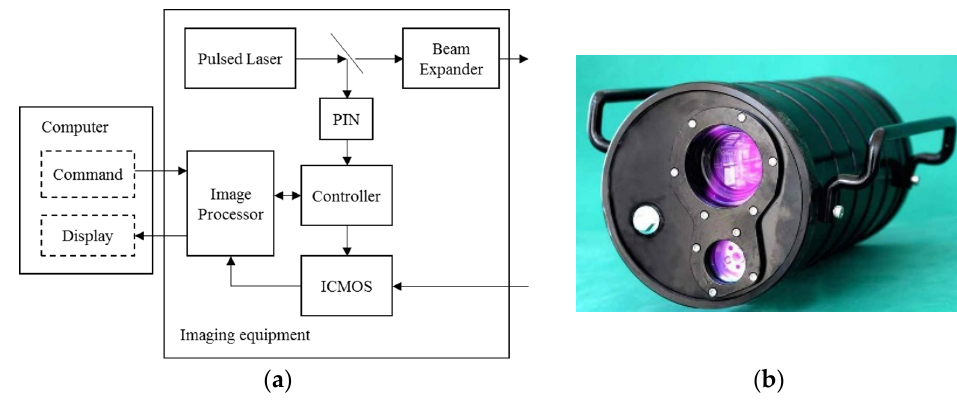
Figure 7. Component of PLRGI equipment. ( a ) Principle of the system; ( b ) Front view of the system. Experiments are carried out in a boat tank, which size is 175 m × 6 m × 4 m (length × width × depth). The wall of the boat tank is rough and the reflectivity of light is low. The PLRGI system is placed at 1m underwater as shown in Figure 8.